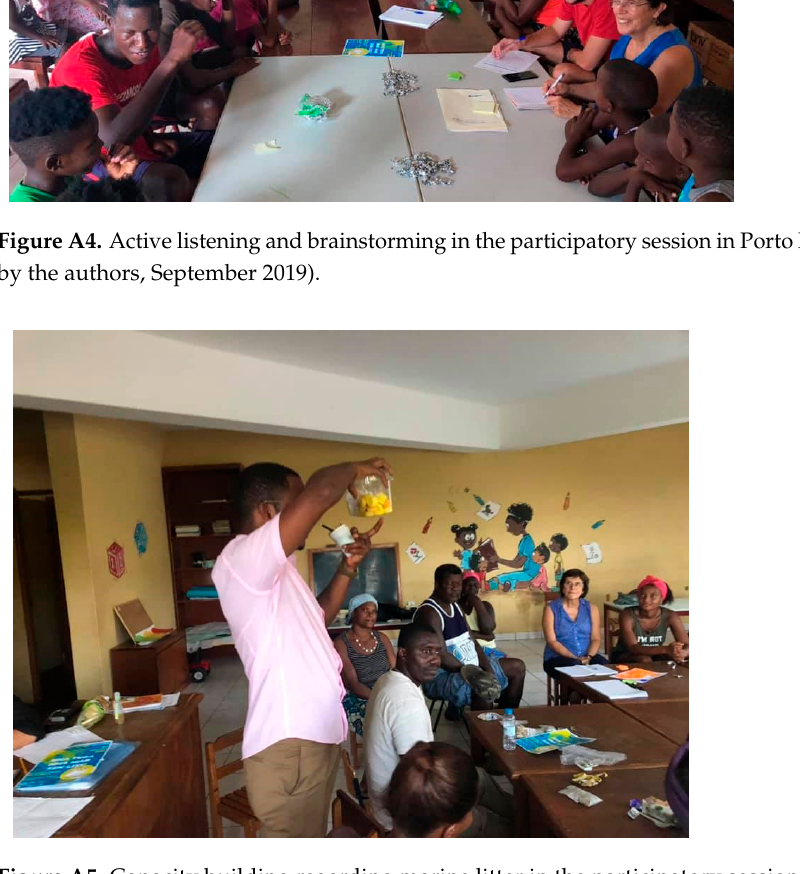
Figure A5. Capacity building regarding marine litter in the participatory session in Porto Gouveia. (photos by the authors, September 2019).